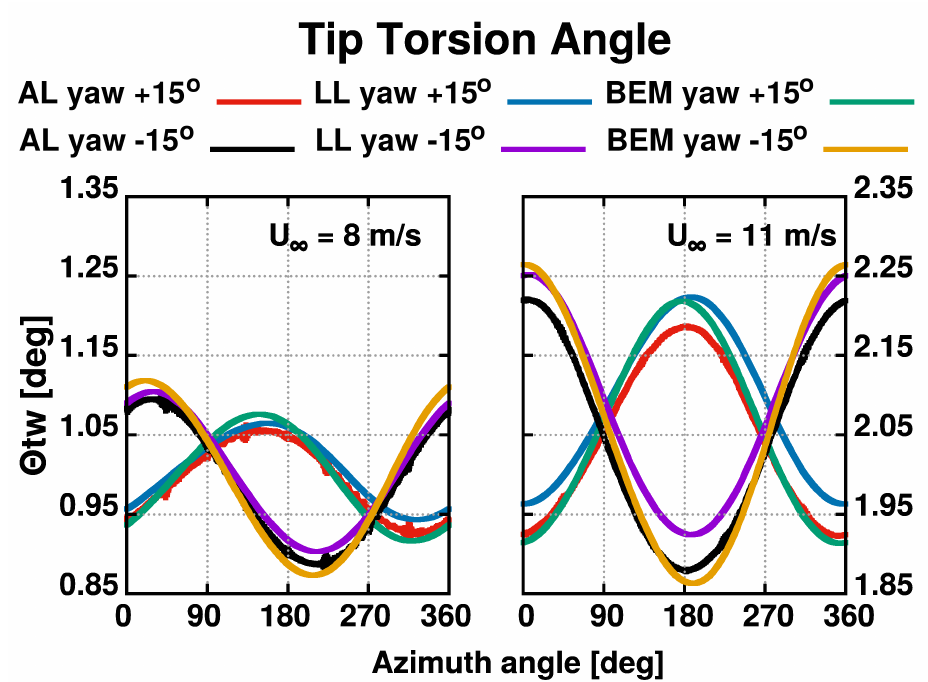
Figure 29. Torsion angle of blade tip at 15 ◦ yawed wind speed at 8 and 11